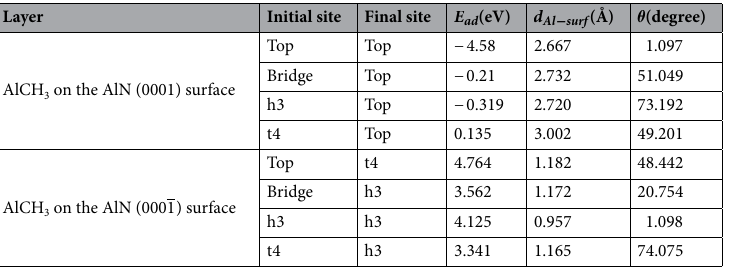
Table 1. Structure parameters, stable adsorption sites at AlCH 3 adsorbed on the AlN (0001) and AlN (000 1 ) surfaces, and the corresponding adsorption energies. E ad represents the adsorption energy. d Al − surf represents the average distance of Al atom in AlCH 3 with the topmost surface. θ represents the angle between the C–Al bond and the topmost